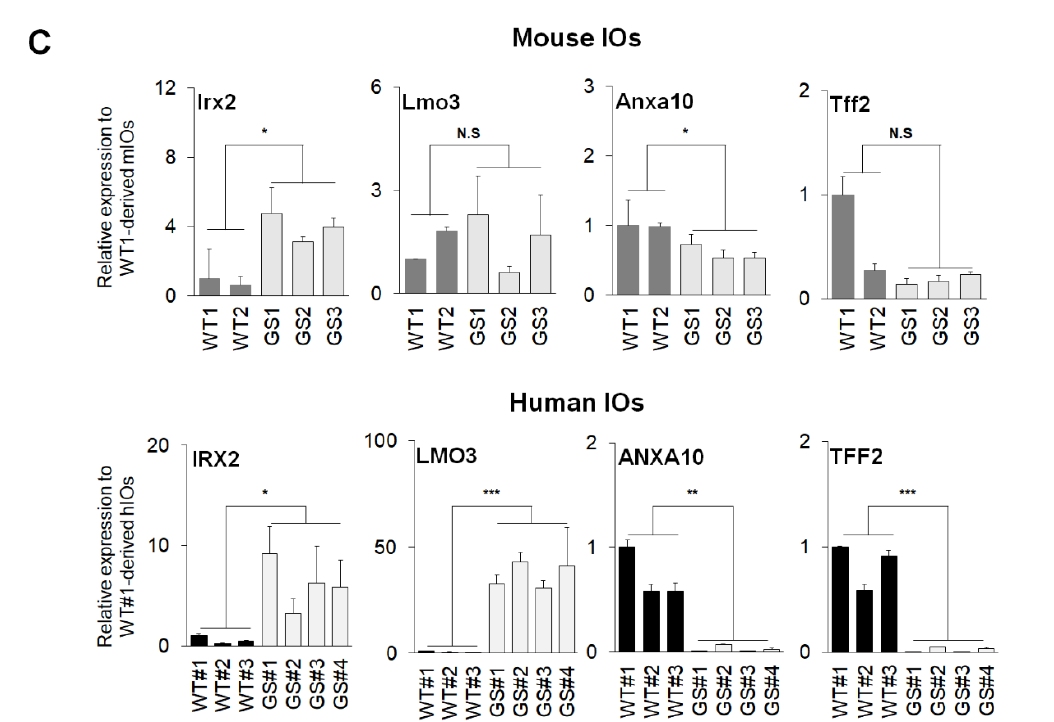
Figure 3. Identification and validation of commonly up-regulated or down-regulated factors based on the transcriptome analysis. ( A ) Venn diagram of the identification of commonly regulated factors between mIOs and hIOs. DEGs were selected on the basis of a > 5-fold change (FC). Four factors (Iroquois homeobox 2; IRX2 , LIM domain only 3; LMO3 , AnnexinA10; ANXA10, and Trefoil factor 2; TFF2 ) were a ffi liated to the intersection. ( B ) Transcriptome analysis data of commonly regulated genes. ( C ) Quantitative Real-Time PCR (qRT-PCR) verification of commonly regulated genes, including Irx2 (WT, 0.8132 ± 0.1868, n = 2; GS, 3.953 ± 0.4730, n = 3, p -value 0.0153), Lmo3 (WT, 1.414 ± 0.4138, n = 2; GS, 1.526 ± 0.4898, n = 3, p -value 0.8830), Anxa10 (WT, 0.9925 ± 0.007453, n = 2; GS, 0.5974 ± 0.06272, n = 3, p -value 0.0165), and T ff 2 (WT, 0.6377 ± 0.3623, n = 2; GS, 0.1783 ± 0.02823, n = 3, p -value 0.1903) in mIOs and IRX2 (WT, 0.5759 ± 0.2178, n = 3; GS, 6.148 ± 1.224, n = 4, p -value 0.0124), LMO3 (WT, 0.5873 ± 0.2296, n = 3; GS, 36.96 ± 2.965, n = 4, p -value 0.0001), ANXA10 (WT, 0.7185 ± 0.1408, n = 3; GS, 0.02325 ± 0.01537, n = 4, p -value 0.0021). and TFF2 (WT, 0.8333 ± 0.1256, n = 3; GS, mIOs and WT#1 hIOs, respectively. Data are mean ± standard error of means (SEM) of at least three independent experiments. p -values were analyzed using the unpaired two-tailed Student’s t -test (* p < 0.05, ** p < 0.005, *** p < 0.001, N.S, not